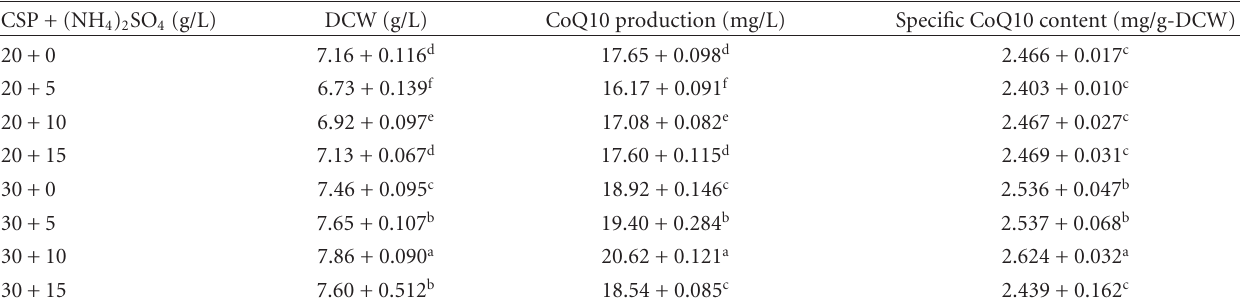
Table 5: E ff ect of complex nitrogen sources on DCW and CoQ10 production by PK38 with batch